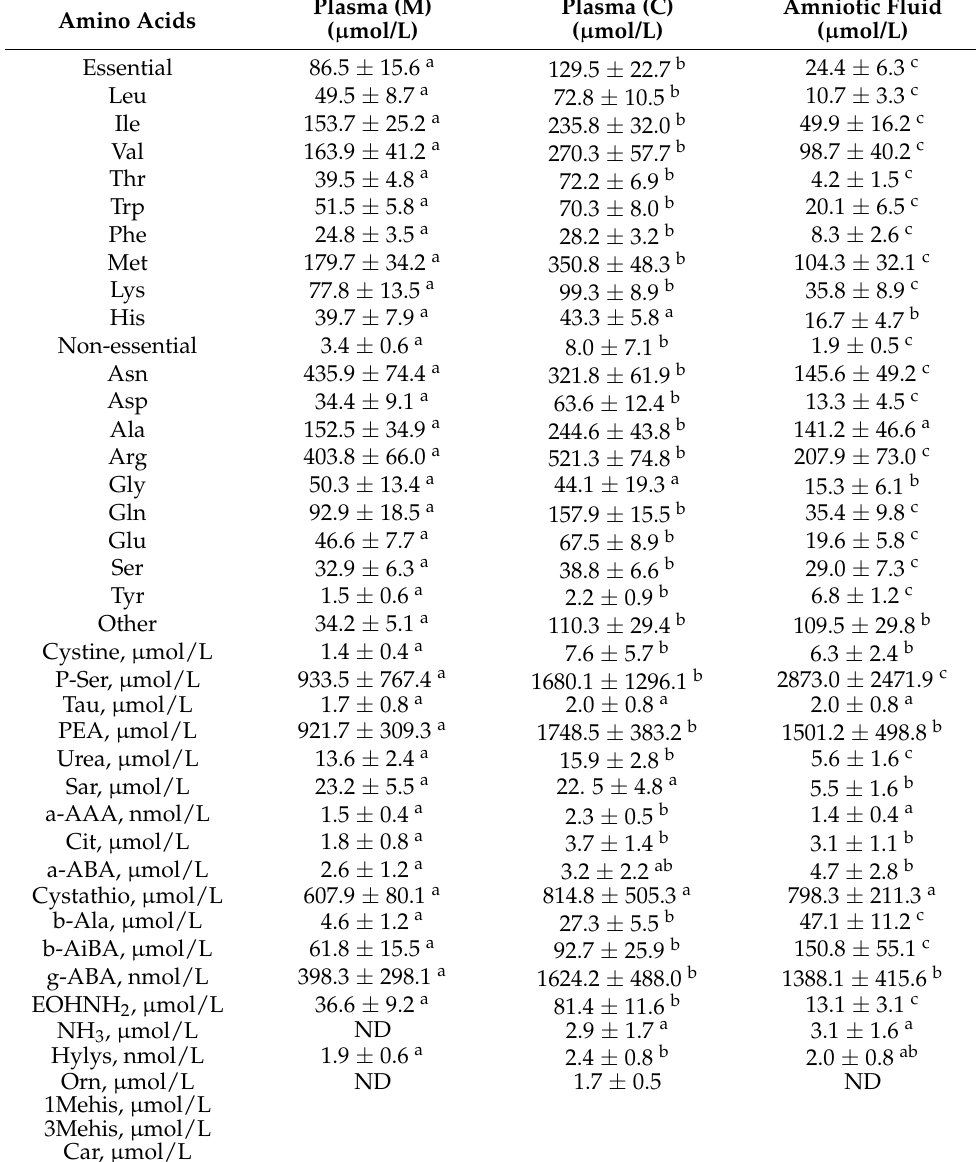
Table 1. The average amino acid contents of each type of sample. Amino